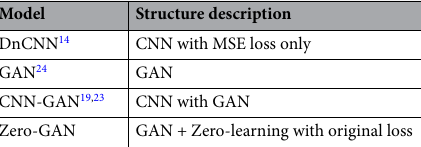
Table 1. Description of comparative network